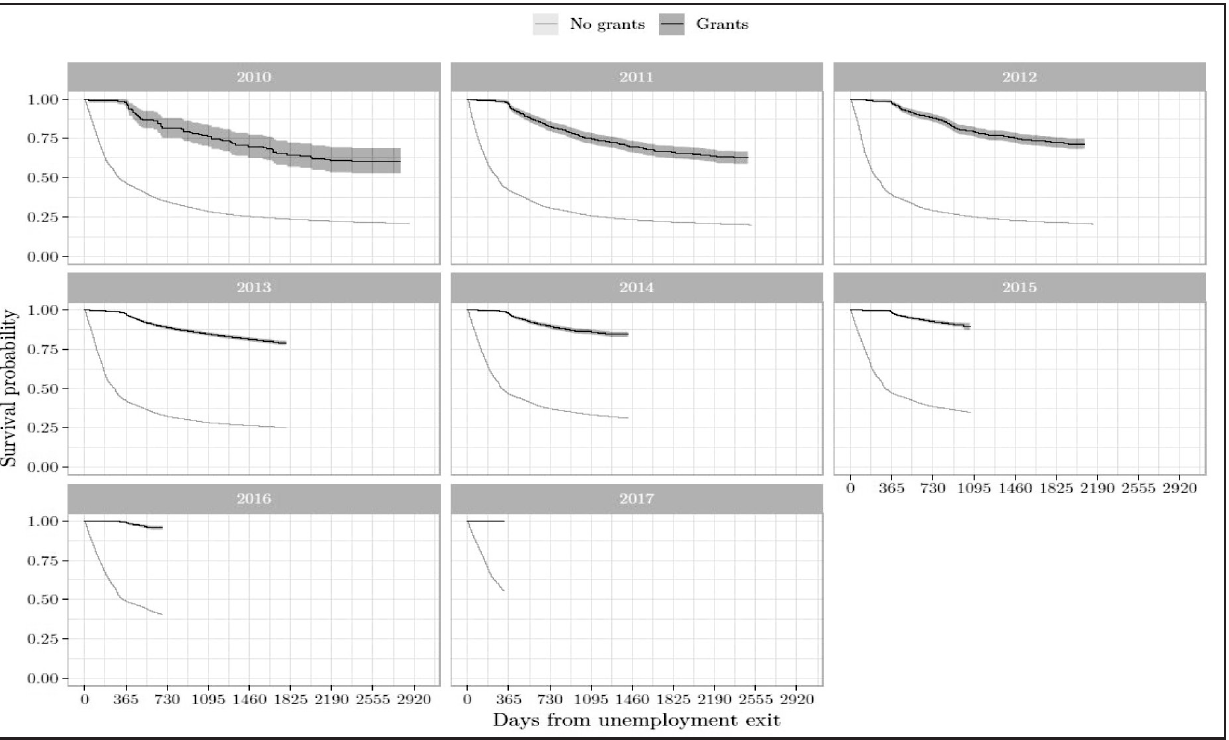
Figure A4 Kaplan–Meier estimates of employment survival by